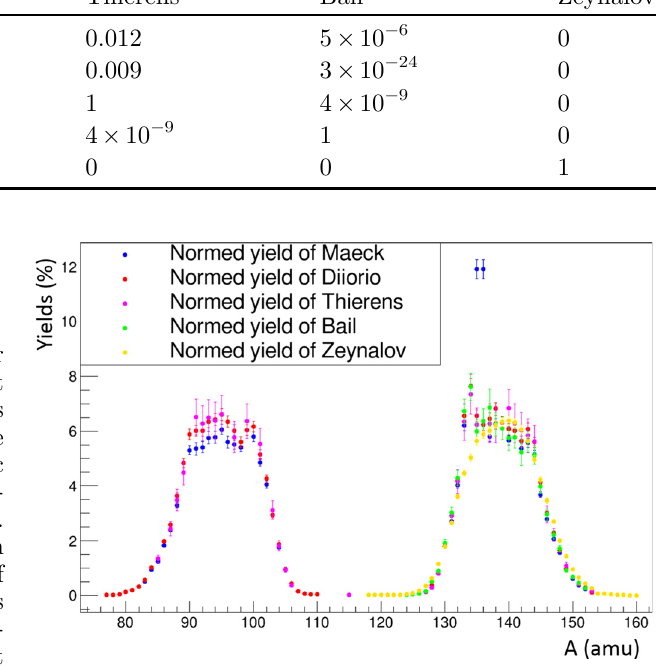
Fig. 1. Cross-normalized data sets of fi ssion yields for fi ve main measurements for the 235 U( n th , f )